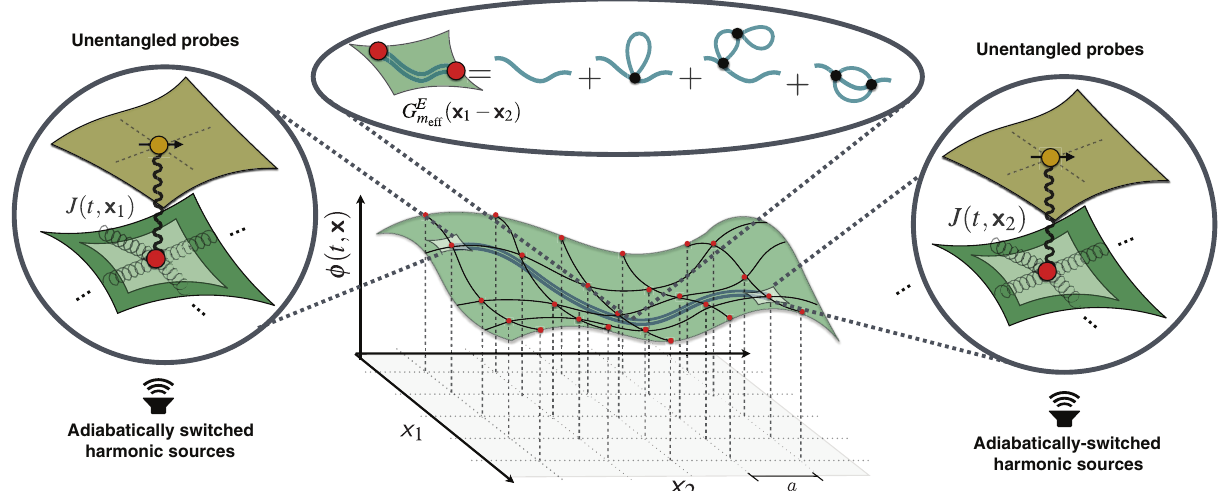
FIG. 2. Scheme of the harmonic sensors for the generating functional: two distant Ising spins at positions x 1 and x 2 are coupled to the real scalar field φ( t , x ) locally by harmonic Ising-Schwinger sources J ( t , x i ) ∝ sin (ω J t − k J · x i ) that is adiabatically switched during the whole probing lapse. As a consequence, the scalar bosons will mediate an effective Ising interaction between the spins, which is represented by a double blue line. In the upper inset, we depict the strength of this spin-spin interaction, which is effectively controlled by a dimensionally reduced Euclidean propagator of the scalar field. In the presence of quartic couplings, this propagator will include all possible scattering events that can be represented in terms of Feynman diagrams, as displayed in the inset up to second order of the quartic interaction